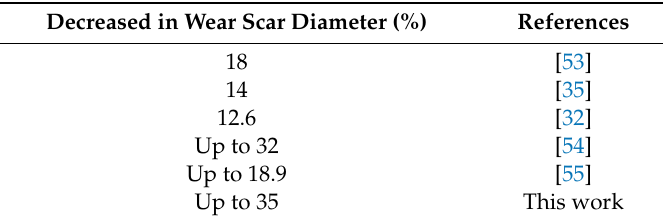
Table 1. Comparison of the tribological performance between the modified GNPs and those of previous works.